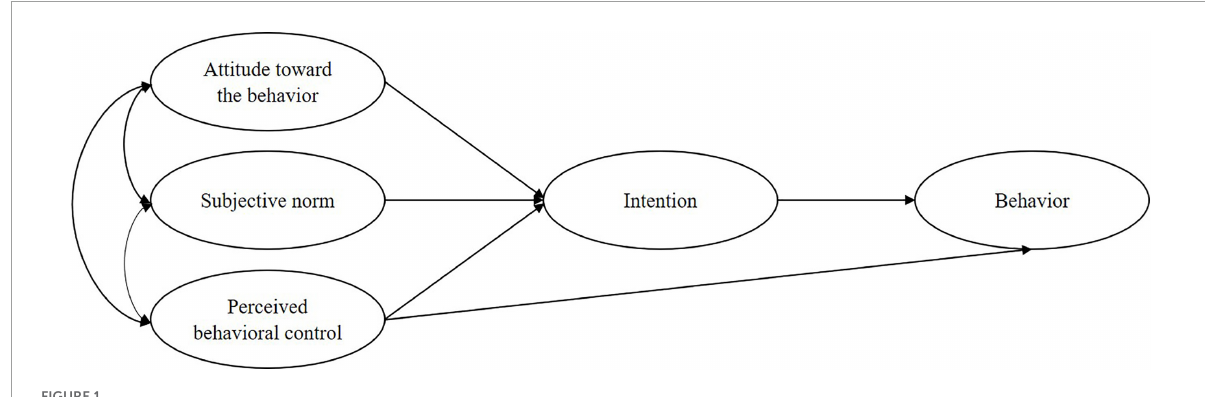
FIGURE1 The Theory of Planned Behavior [oriented to Ajzen (1991, p.